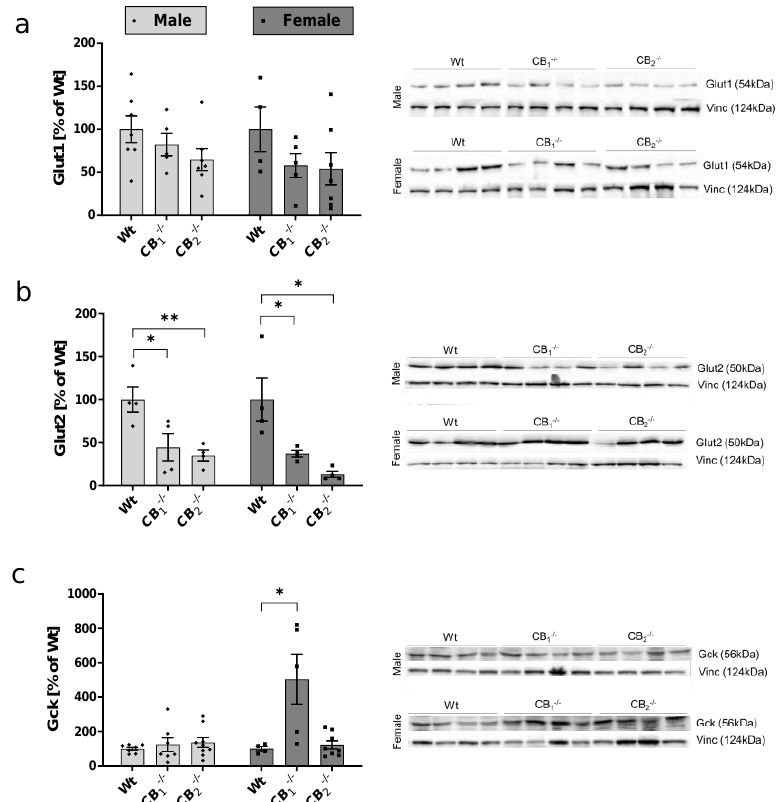
Figure A3. Western blot analysis of glucose transporters (Glut1, Glut2) and glucokinase (Gck) in pancreatic tissue analysing male and female wild-type (Wt) mice and cannabinoid receptor knockout mouse lines (CB 1 − / − , CB 2 − / − ) separately. ( a ) Glut1 seemed to be decreased in CB 1 − / − and CB 2 − / − knockout mice of both sexes. ( b ) Glut2 protein was significantly decreased in CB 1 − / − and CB 2 − / − knockout mice of both sexes. ( c ) Gck protein level was increased in female CB 1 − / − mice. Analysis of male and female mice was done separately on di ff erent immunoblots, defining male and female Wt protein levels as 100%. A representative western blot of each protein is shown in the right column showing specific single bands as indicated. Vinculin (Vinc) was used as control protein. Values are presented as mean ( ± S.E.M.) with n = 4–9 mice per group. * p < 0.05; ** p < 0.01 for comparisons within male or female Wt and knockout mice; unpaired t -test.